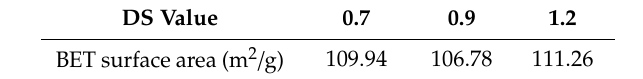
Table 1. The BET surface area for di ff erent DS value CMC aerogels.